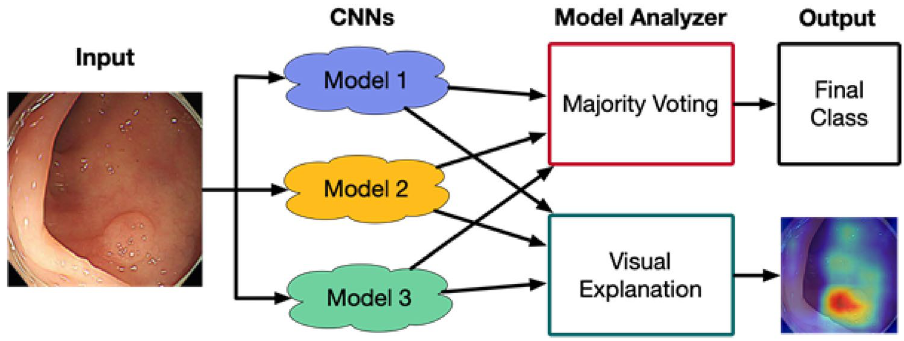
Figure 3. Overview of computer aided diagnosis (CAD) system based on 3 CNN models. Each CNN model independently predicts the class of input colonoscopic image. The following model analyzer decides final class from the predictions and provides the corresponding visual